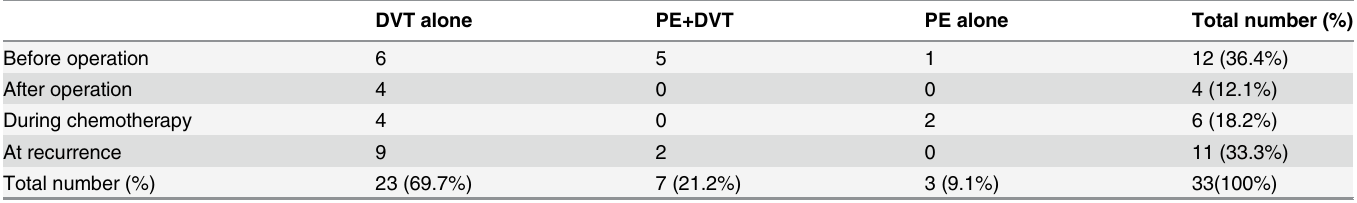
Table 2. Features of venous thromboembolism (VTE) in ovarian clear cell